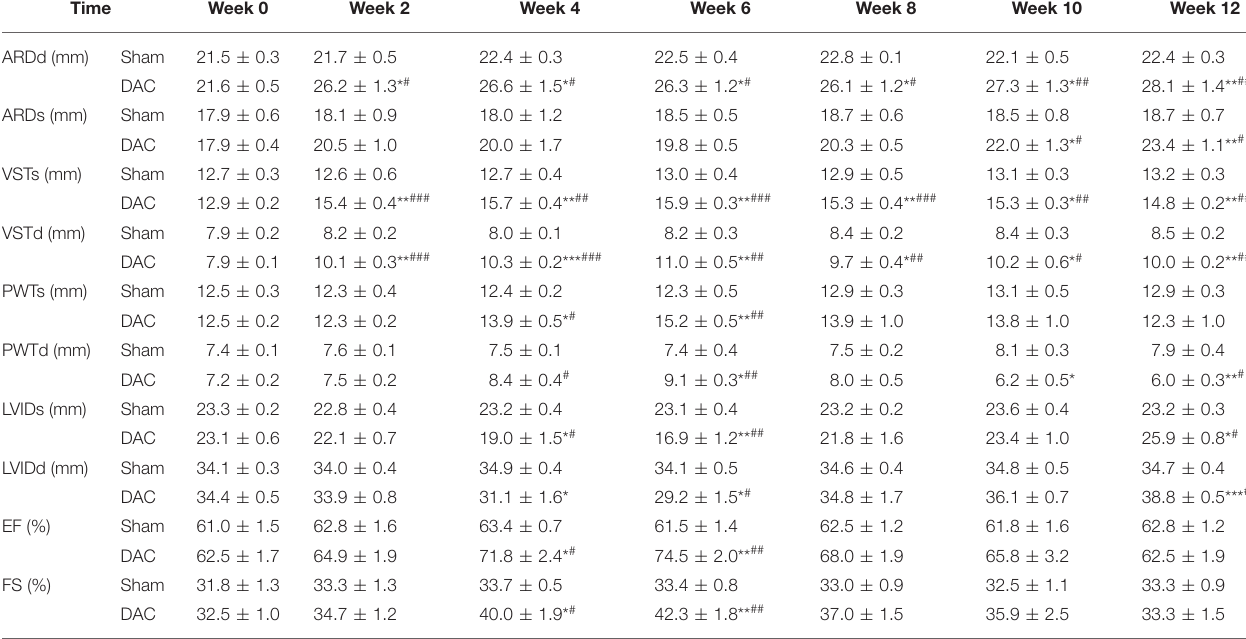
TABLE 3 | Echocardiographic analysis of the sham and DAC groups. Time